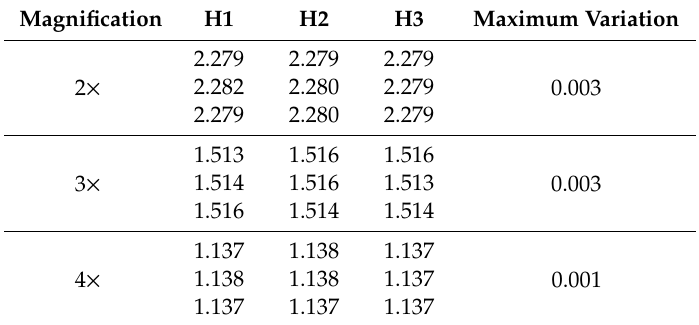
Table 4. The pixel equivalent under di ff erent object distances ( µ m /